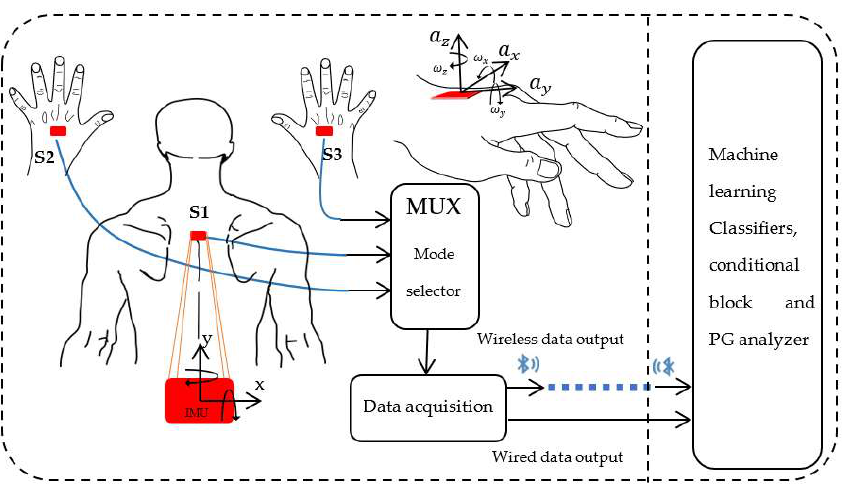
Figure 2. WISP: The left side shows the IMUs placements, the MUX for mode switching, and the data extractor used to extract the raw data. All components on the left side are contained in the wearable part of the system. The right side shows that the wearable part of the system is linked to a processing hardware that uses a classifier to recognize the gestures.